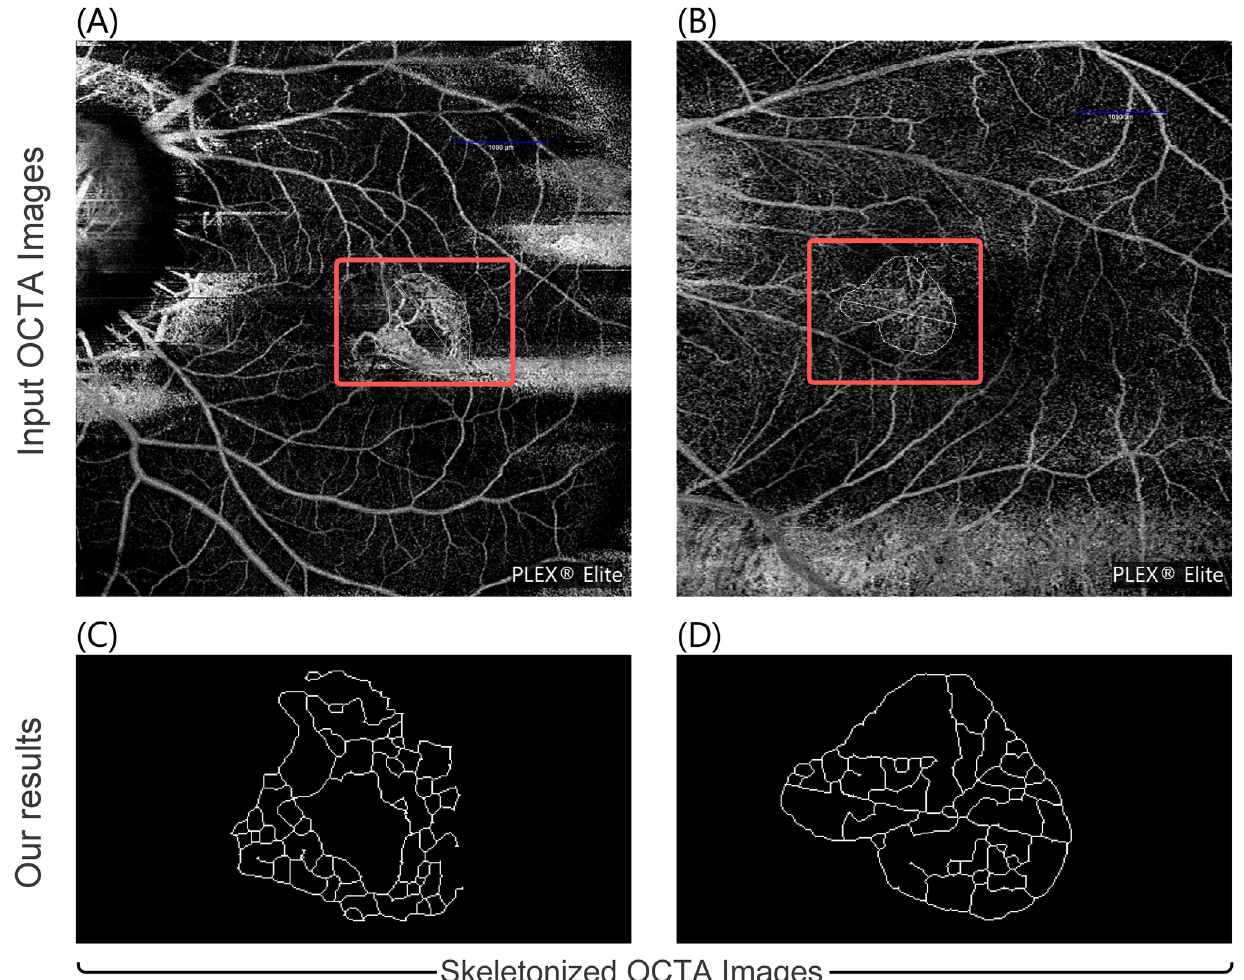
Fig 1. Skeletonization and quantitative analysis of OCTA images. We present an ImageJ macro that processes OCTA images of mCNV (A), (B). Our work enables users to perform quantitative analysis on skeletonized images (C), (D) of active mCNV lesions using nine computed biomarkers.